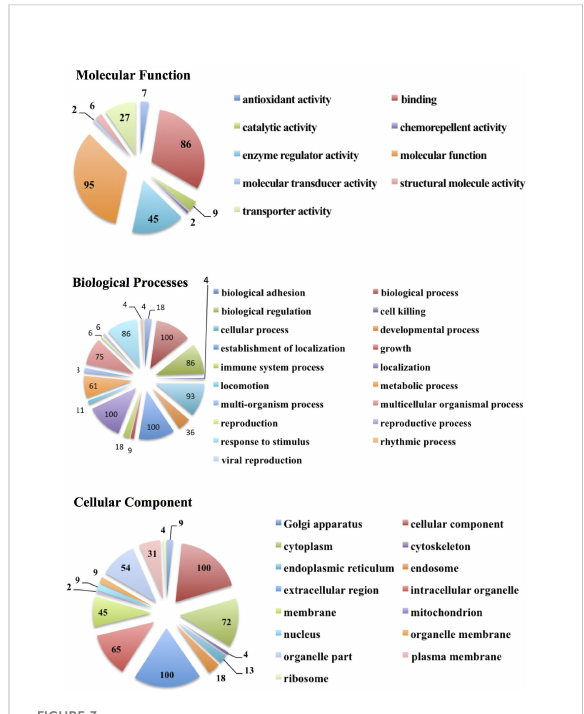
FIGURE 3 Protein ontology analysis showing the number of EV proteins from all subject groups and categorized according to molecular functions, biological processes, and cellular